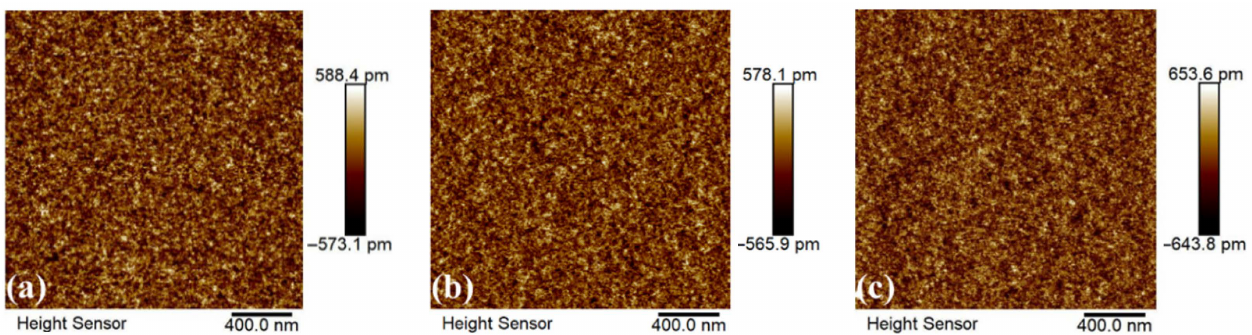
Figure 5. AFM images of Ru/C multilayers under different annealing temperatures ( a ) as-deposited, ( b ) 300 ◦ C, and ( c ) 700 ◦